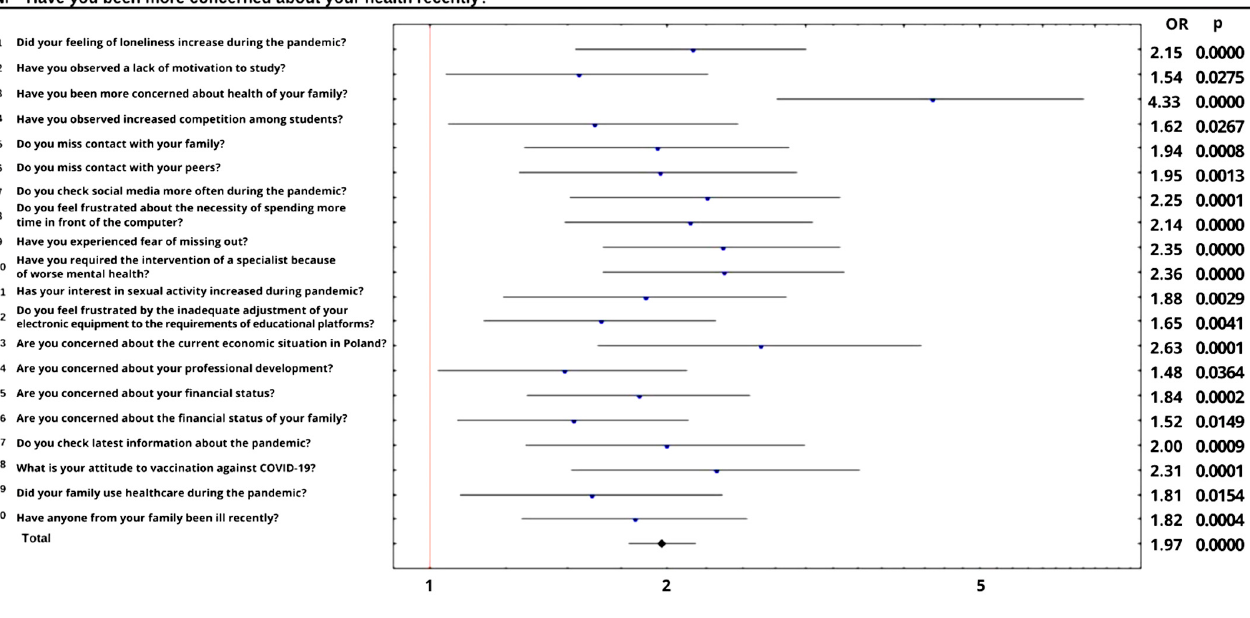
Figure 3. The impact of health anxiety on other variables.